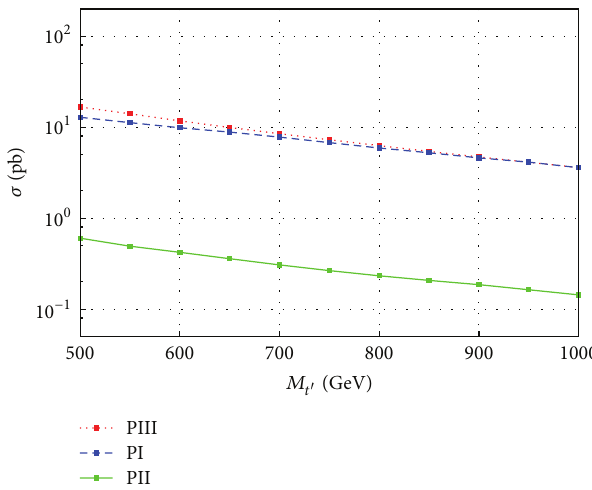
Figure 2: The cross section for the process 𝑝𝑝 → 𝑡𝑉+𝑋 depending on the mass for parameter sets PI, PII, and PIII at the center of mass energy √ 𝑠 = 13